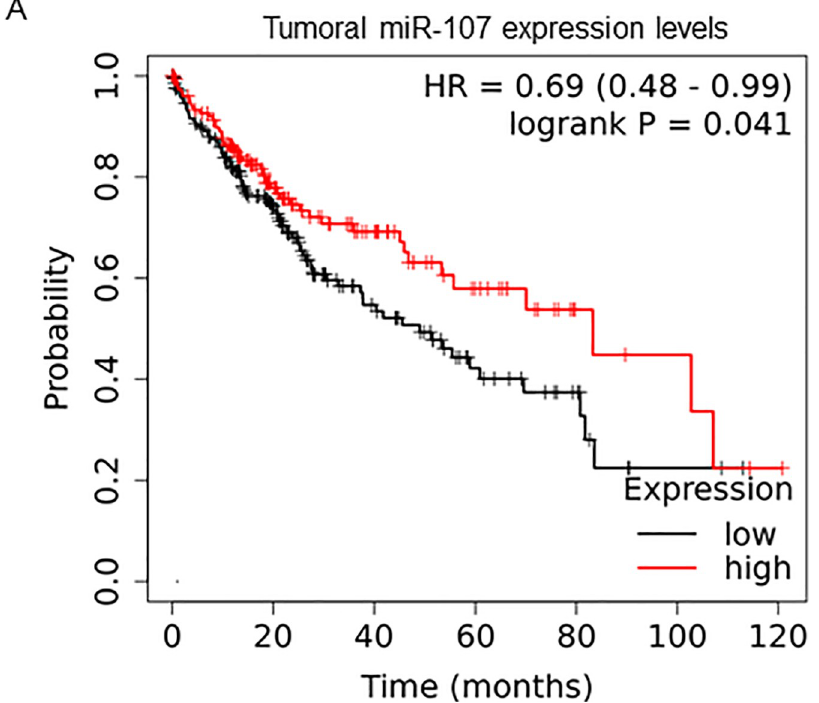
Fig 1. MiRNA-107 expression levels in HCC tissue represent a prognostic marker. Kmplot was used to analyze the prognostic value of miR-107 in HCC in NGS data from TCGA, GEO, and EGA (n = 372 patients). Patients were automatically split by Kmplot in two groups with low (n = 214) and high (n = 158) levels for miR-107 expression (expression range, 70–989, cut off expression: 270,22). Overall survival of HCC patients with high tumoral miR-107 expression levels is significantly higher compared to patients with low miR-107 expression levels (HR 0.69, 95% CI 0.48–0.99, p =